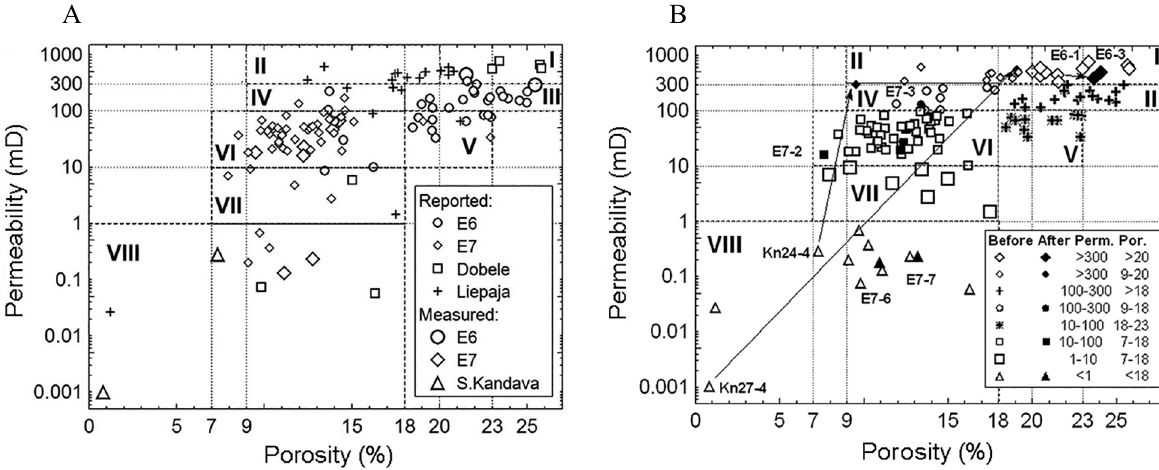
Fig. 2. Gas permeability versus porosity of the reported and measured sandstones of the Deimena Formation from two offshore and three onshore structures in eight reservoir quality classes I–VIII (Tables 1, 2) based on: ( A ) 115 samples reported and measured before the alteration experiment in terms of five structures; ( B ) 115 samples reported and measured before the alteration experiment (empty symbols) and 12 samples measured after alteration (black symbols) in terms of eight reservoir quality classes. Perm., gas permeability; Por.,